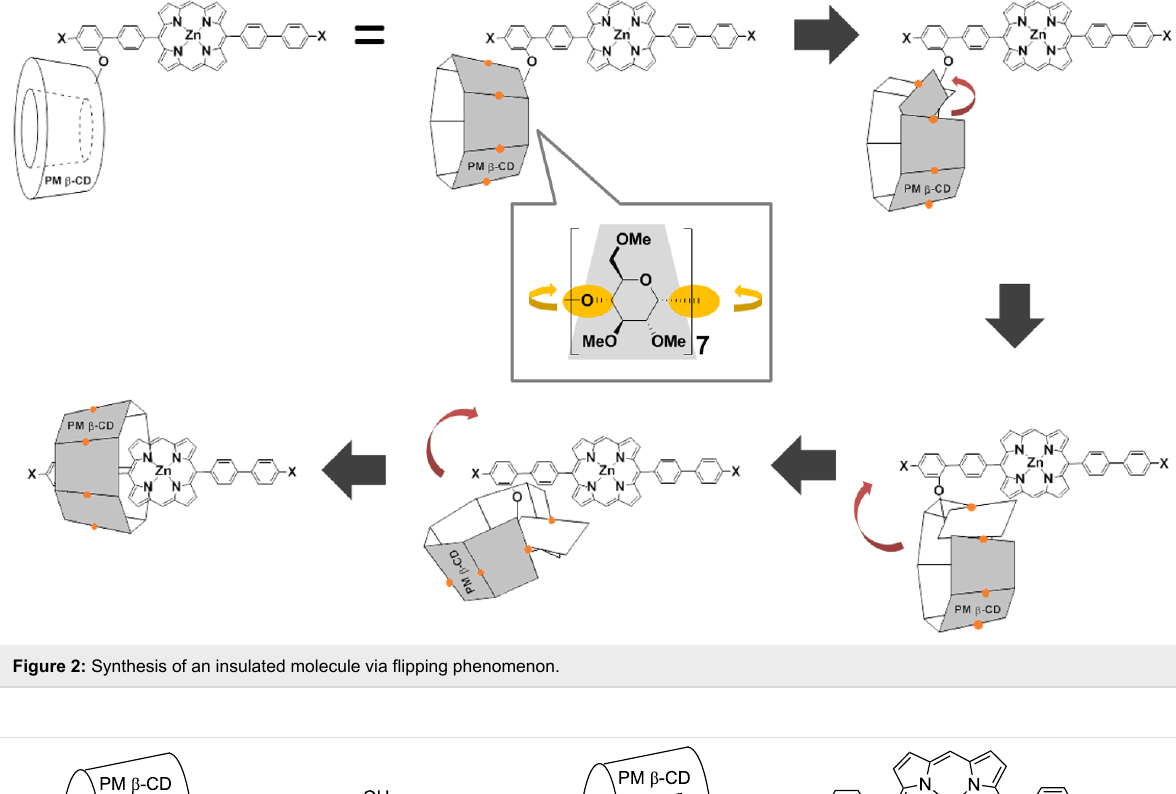
Figure 2: Synthesis of an insulated molecule via flipping phenomenon.